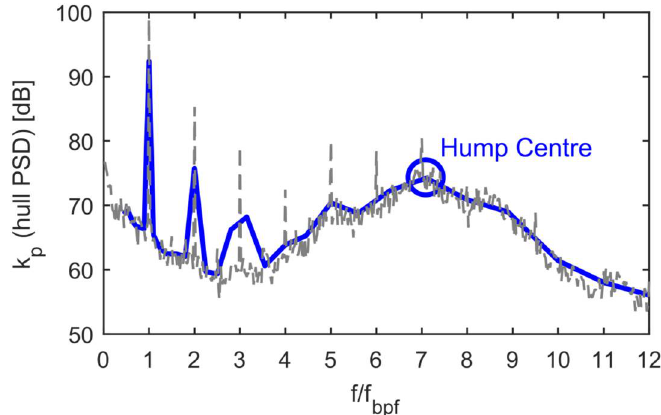
Figure 5. Example of a non-dimensional hull pressure power density spectrum of a two-bladed research propeller. The solid line is the 1/6 octave band smoothened spectrum.